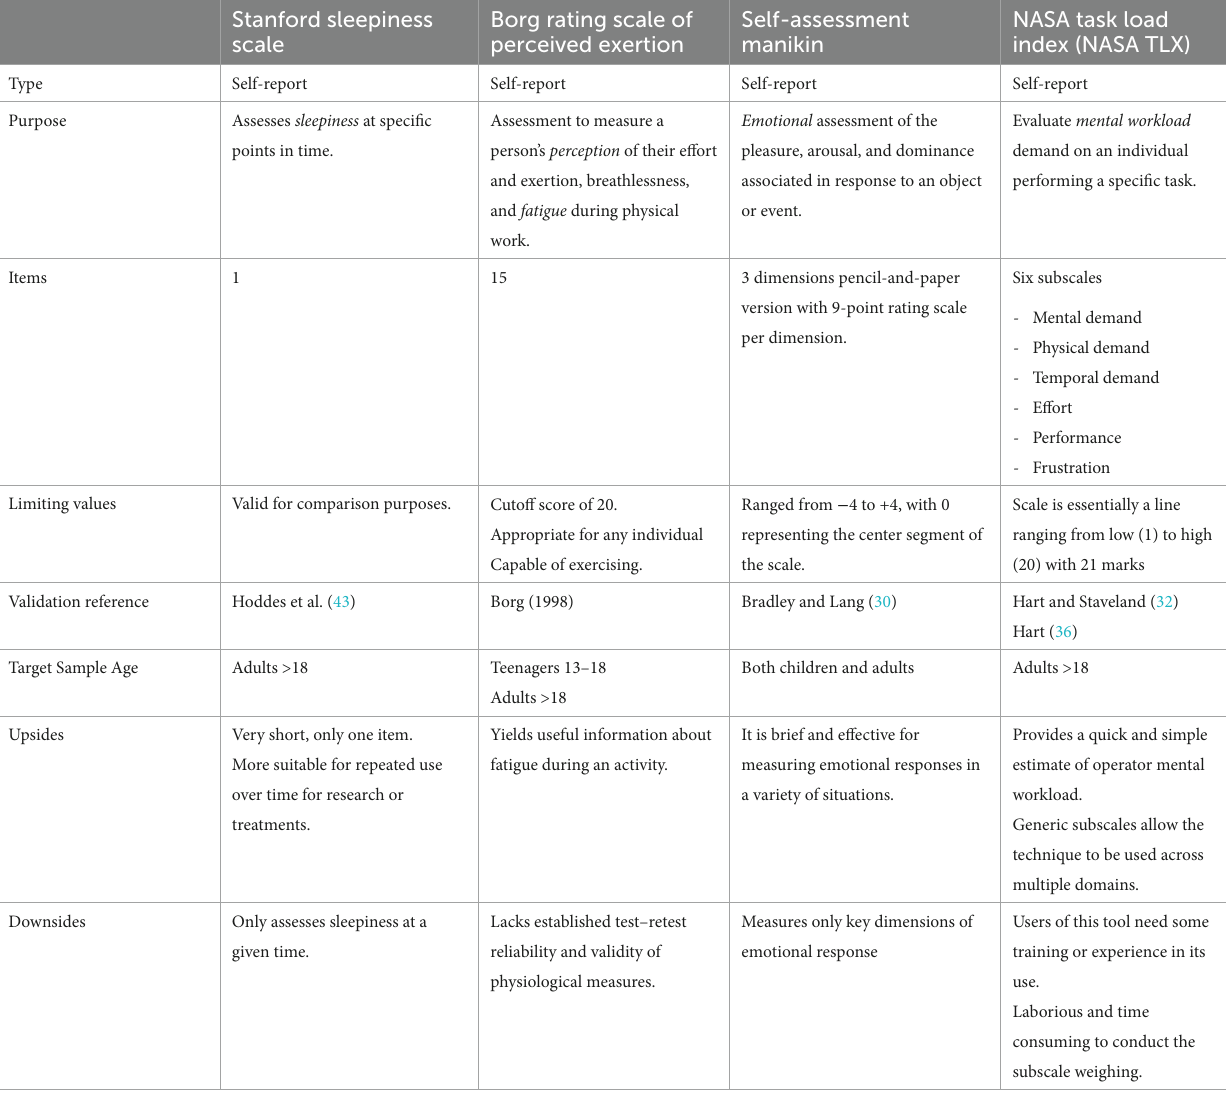
TABLE 2 Scales used to assess sleepiness and